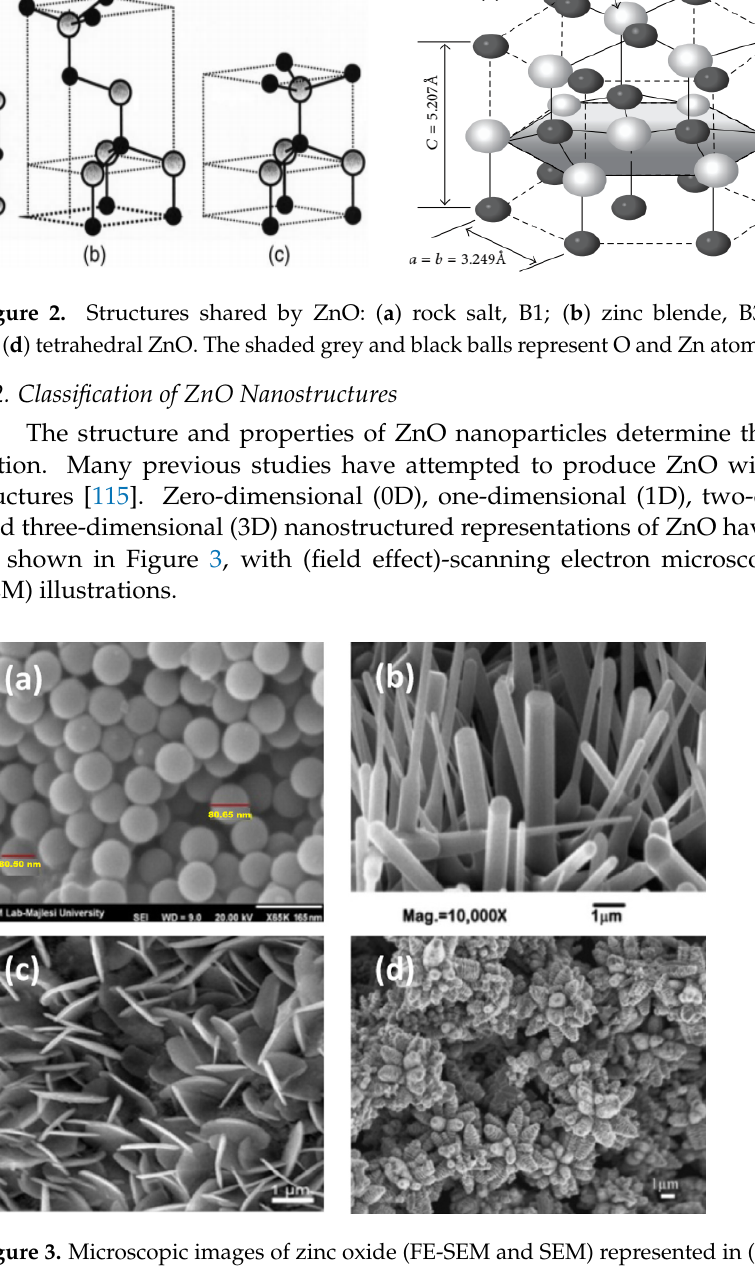
Figure 3. Microscopic images of zinc oxide (FE-SEM and SEM) represented in ( a ) 0D, ( b ) 1D, ( c ) 2D, ( d ) 3D [53].